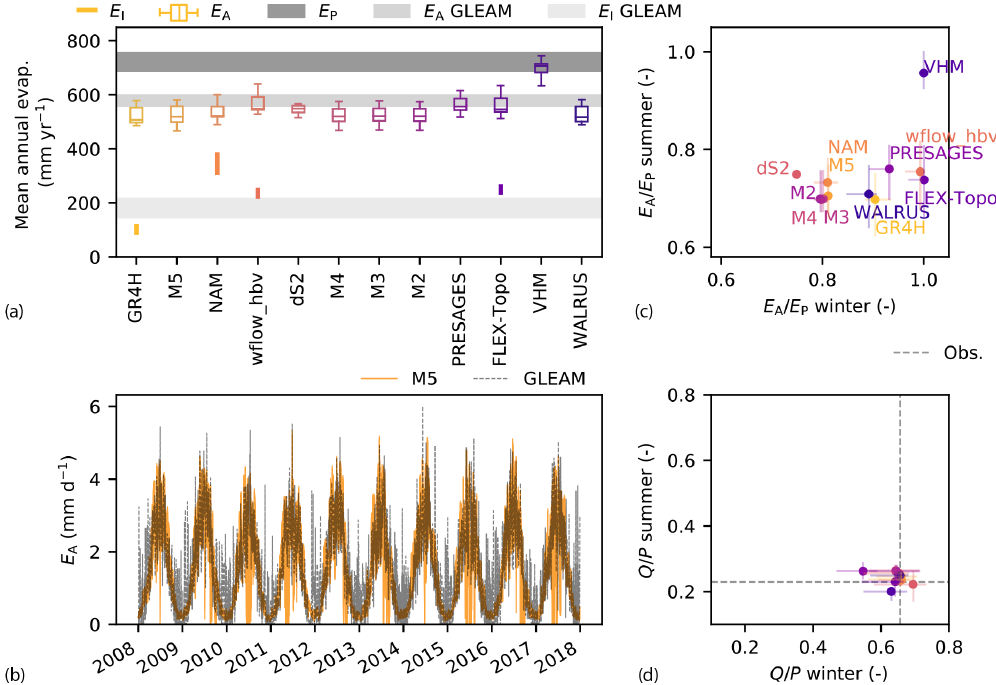
Figure 4. Evaluation of modeled evaporation for the Ourthe upstream of Tabreux for the period 2008–2017. (a) Modeled mean annual actual evaporation E A and minimum–maximum range of mean annual interception evaporation E I for hydrological years between 2008 and 2017 across feasible parameter sets. The dark grey shaded area shows the range of potential evaporation E P used as input for the models. The light grey shaded area shows GLEAM actual and interception evaporation. (b) Daily actual evaporation from GLEAM and modeled by the M5 model. (c) Summer against winter E A / E P ratios for each model (median and 25th/75th percentiles across parameter sets). (d) Summer against winter runoff coefficient Q/P for each model (median and 25th/75th percentiles across parameter sets), plotted on the same scale. The dashed grey lines indicate the observed median runoff coefficients in summer and